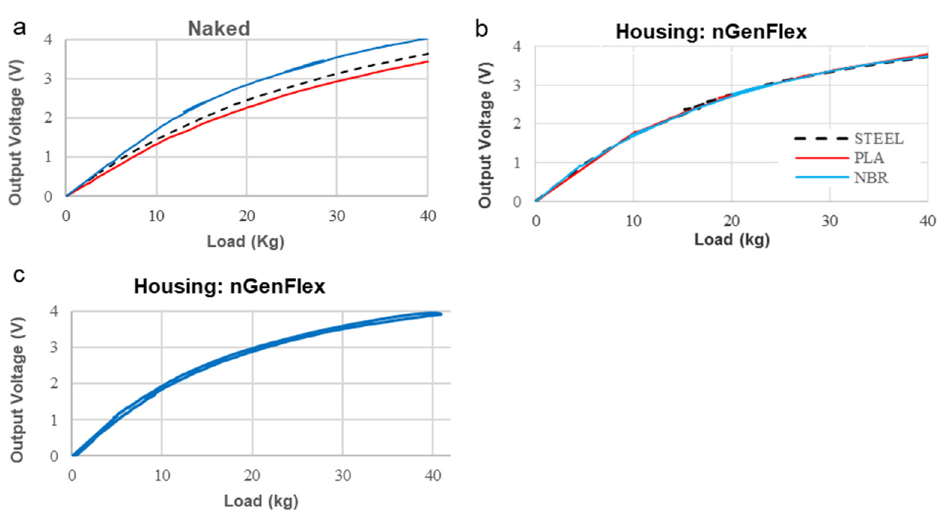
Figure 3. ( a ) Load–response curves for naked sensor tested with pucks of different materials. ( b ) Load–response curves for housed sensor (nGen_Flex) tested with pucks of different materials. ( c ) Full-response curve for a housed sensor (nGen_Flex housing) showing the small difference between loading and unloading. For the sake of clarity, only the loading part of the curve is shown in ( a , b ).